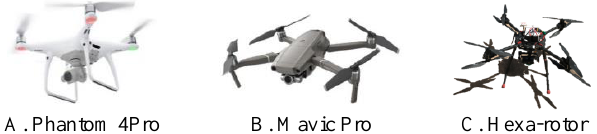
Figure 6. The UAV platforms used.